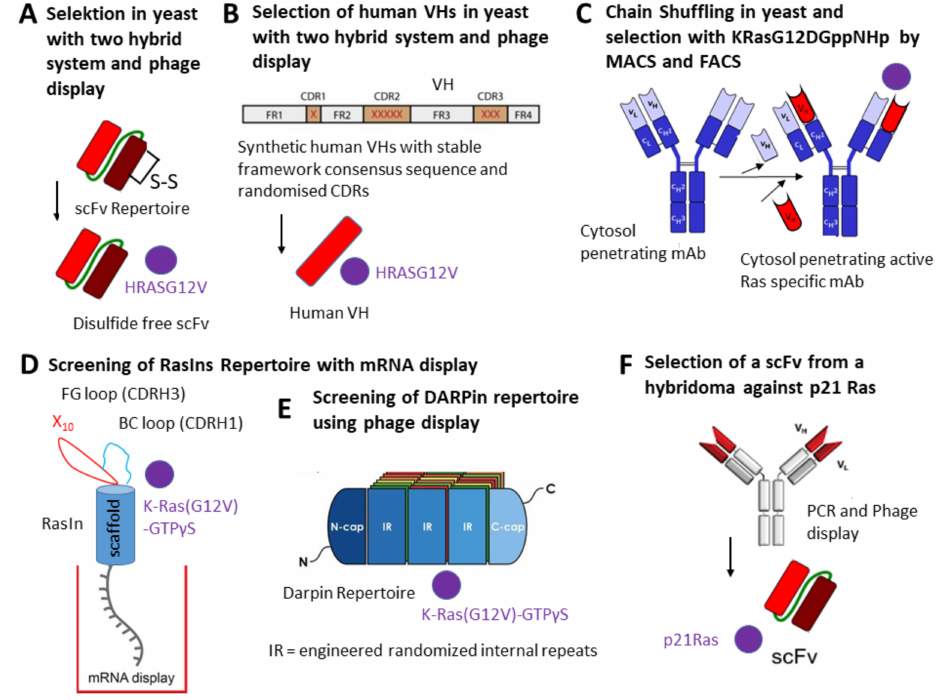
Figure 3. Strategies used to select intrabodies against Ras